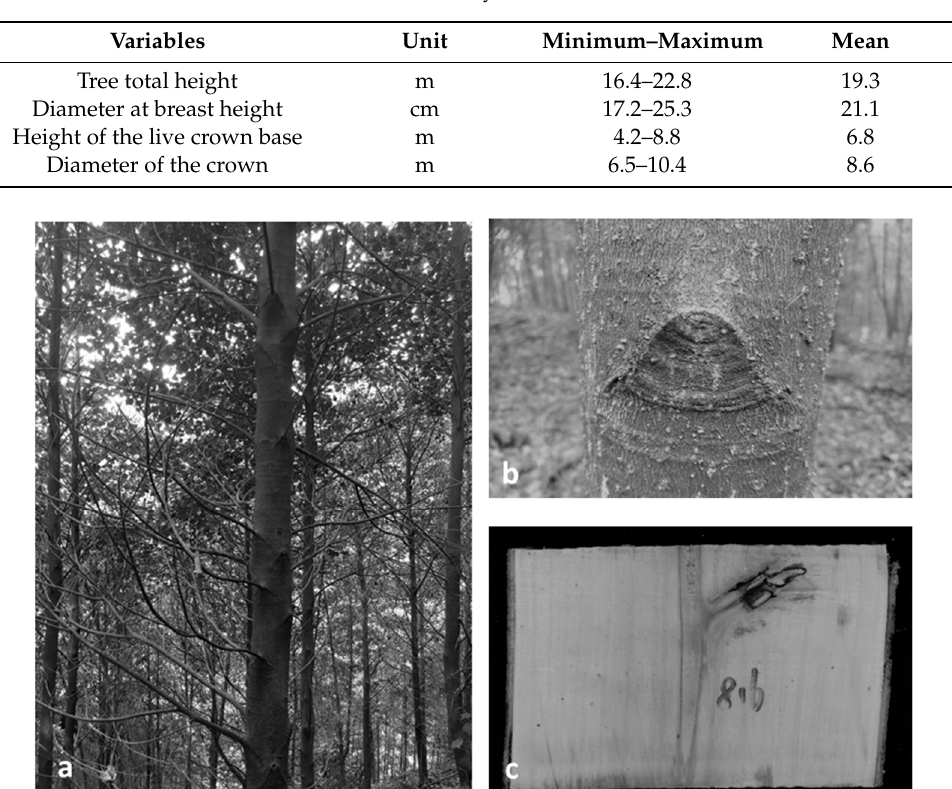
Figure 2. The dead branches below the live crown of a standing Mytilaria laosensis ( a ); the